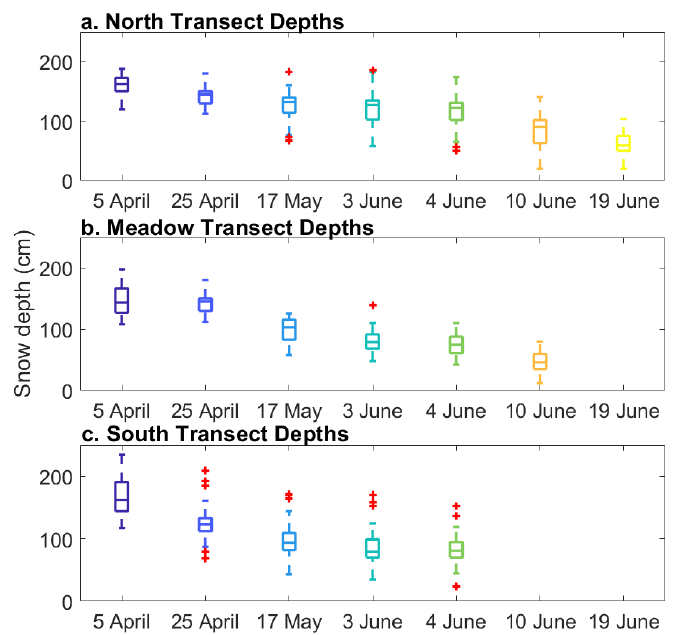
Figure 9. Boxplots displaying probed snow depth variability for the ( a ) North, ( b ) Meadow, and ( c ) South Transects. The boxes extend to the upper and lower quartiles, while the whiskers extend to extreme values not considered outliers. Red crosses denote outliers.